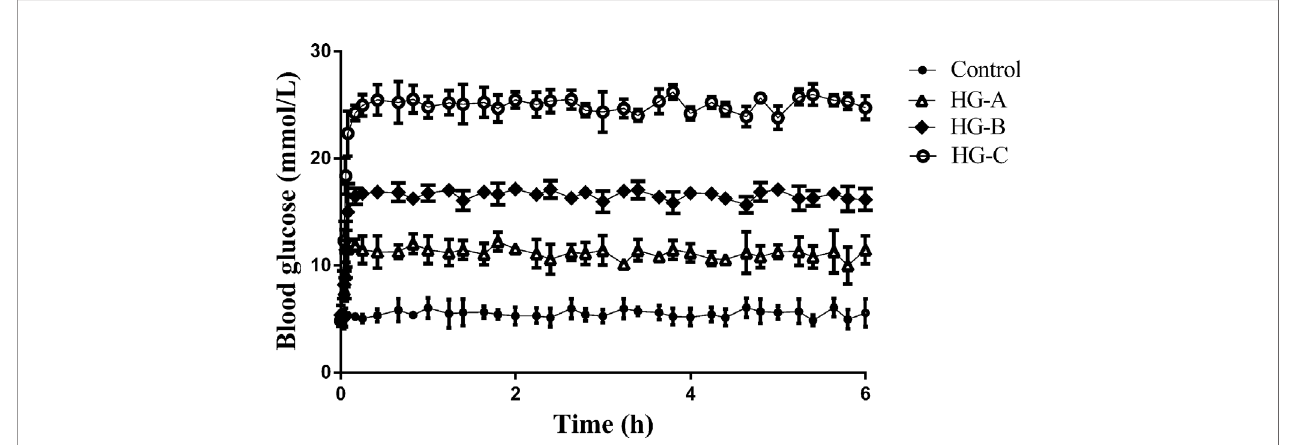
FIGURE 1 | Blood glucose level during hyperglycemic clamp in different groups. N = 10 in each group. Data were expressed as means ± SD in each group. Control, control group; HG-A, hyperglycemia group A; HG-B, hyperglycemia group B; HG-C, hyperglycemia group